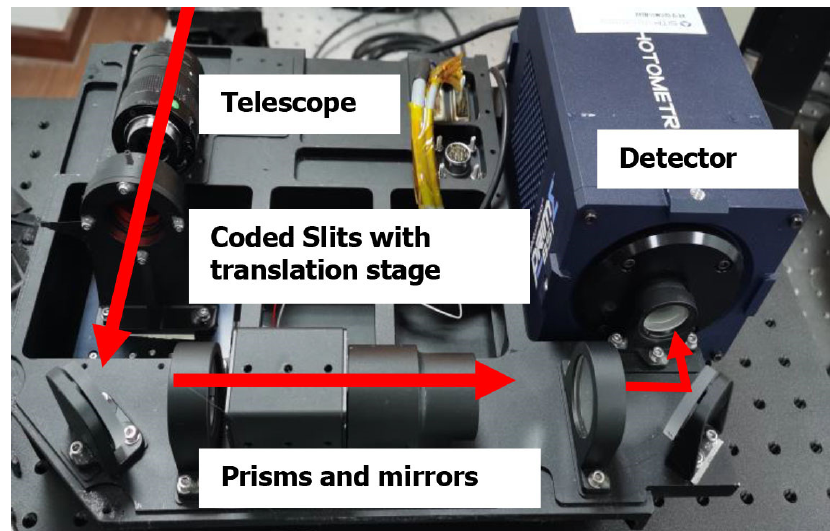
Figure 3. Prototype system for RHVS video acquisition.